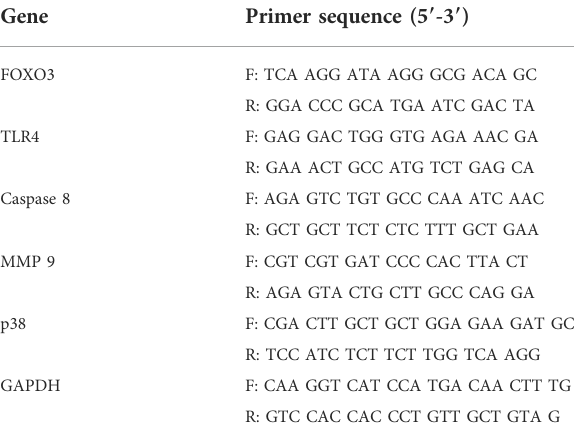
TABLE 1 List of primers and their sequences used for mRNA gene expression validation by RT-PCR.